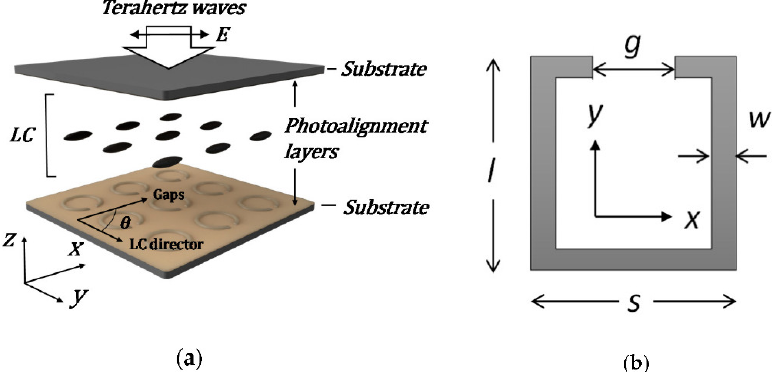
Figure 14. Dimensions of SRRs with different units: ( a ) split ring [73] and ( b ) split square [79]. Reprinted with permission from Refs. [73,79]. 2021 MDPI.